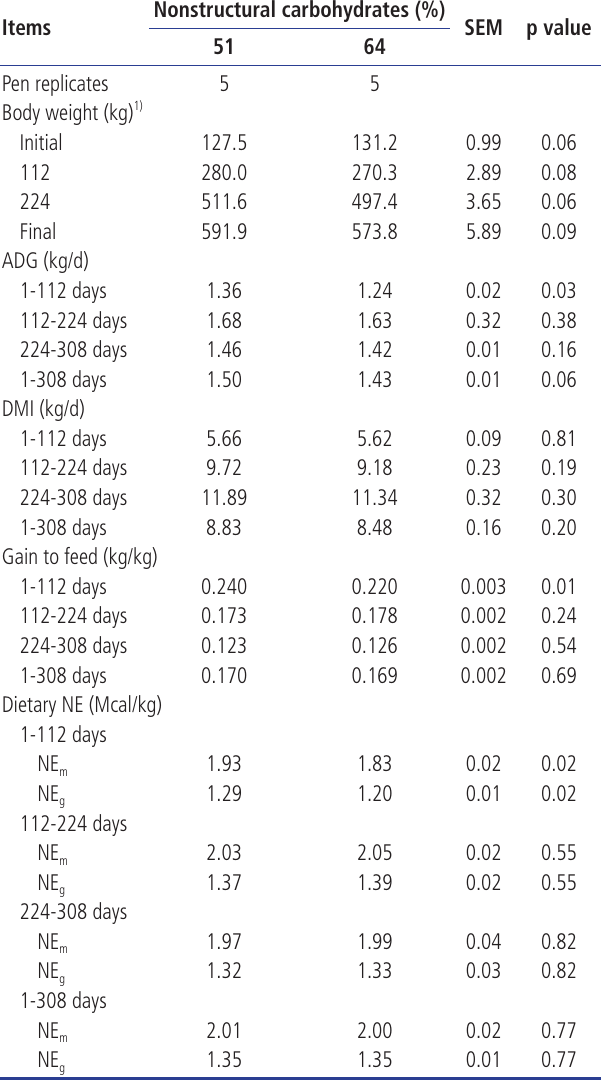
Table 2. Effects dietary nonstructural carbohydrate concentration on growth performance and dietary net energy of Holstein steers on long-term feeding